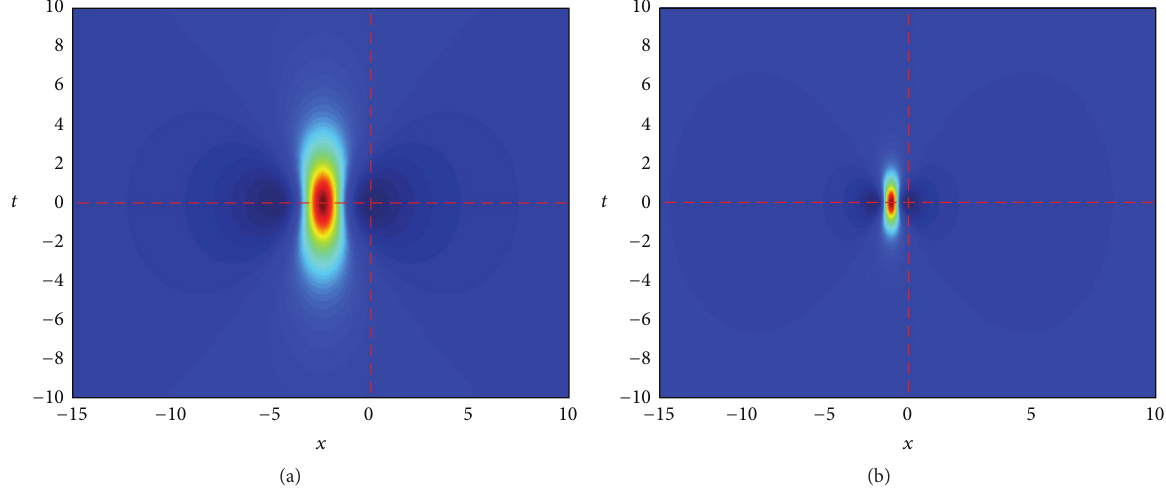
Figure 2: Contour plots of the first-order rogue wave propagation with the gravity fields (a) 𝑏 = 0.5 ; (b) 𝑏 = 1.2 .